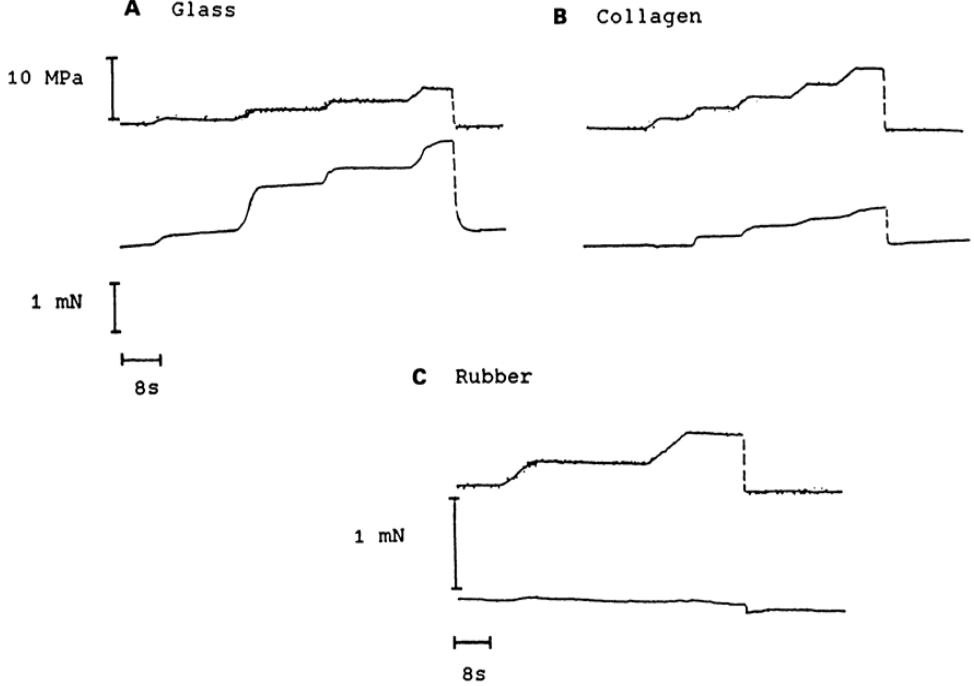
Figure 2. Experimental tension records from glass ( A ), collagen ( B ), and rubber fibres ( C ). In each panel, pressure trace is shown on top of the tension trace and position of the horizontal time scale bar denotes zero tension. Note that isometric tension of glass and collagen increases reversibly with increased pressure; tension of rubber is insensitive to pressure (from Ranatunga et al., [8]).